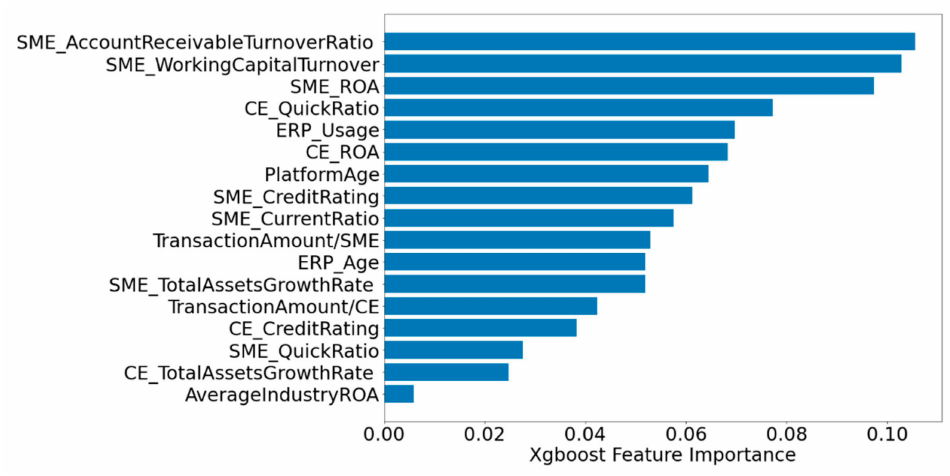
Figure 4. XGBoost feature importance ranking.